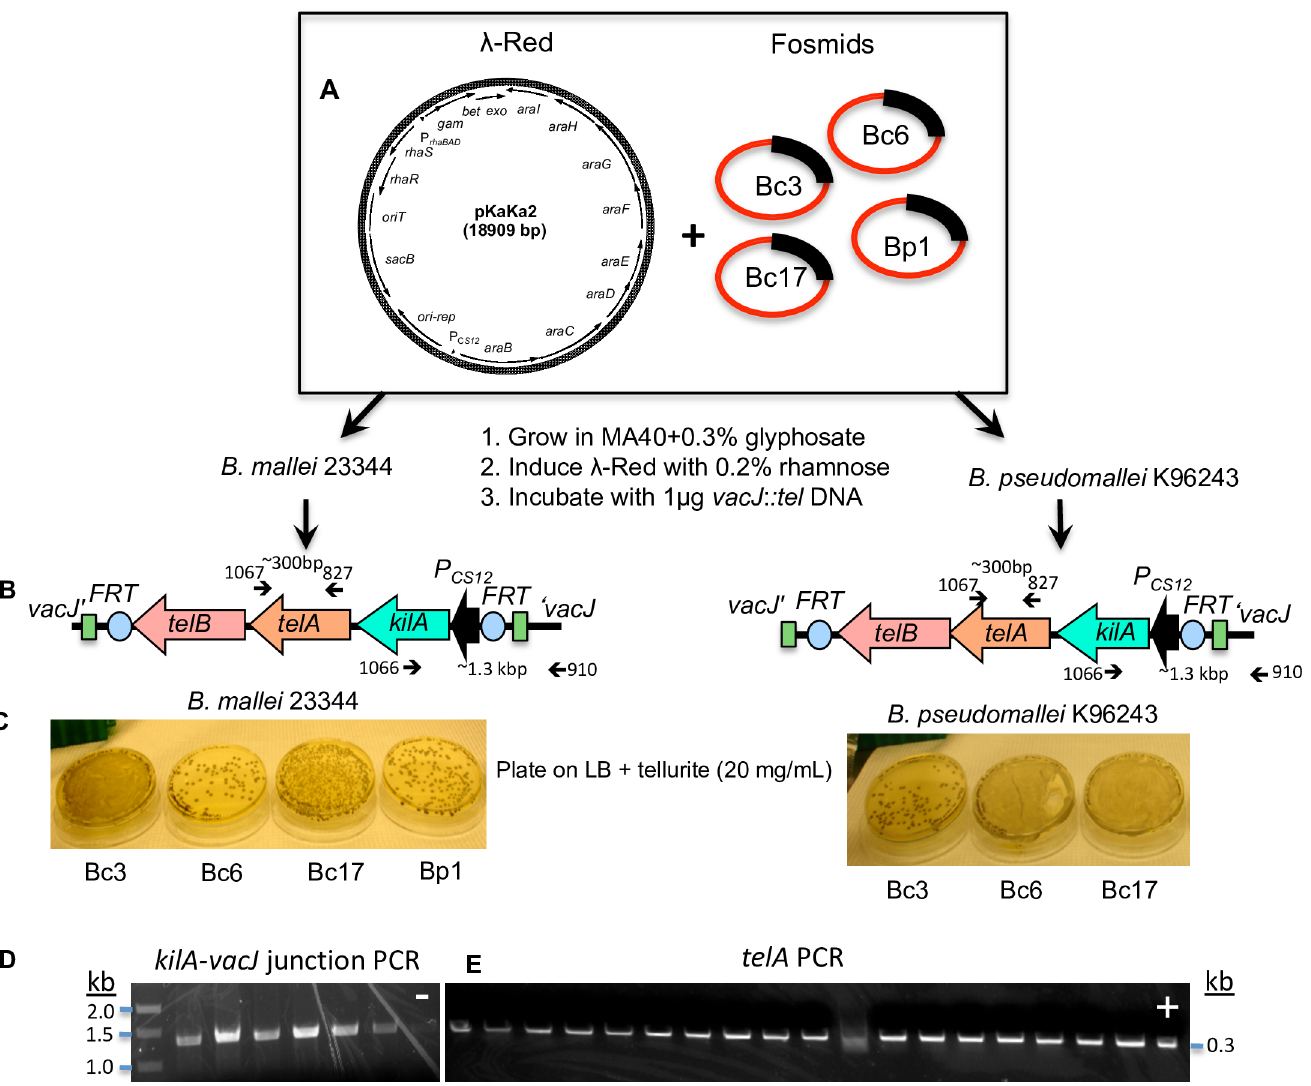
Fig 5. Allelic-replacement in B . mallei strain ATCC23344and B . pseudomallei K96243containing fosmids by natural transformation. (A) λ -Red plasmidpKaKa2and individualfosmid clones were co-transformed into B . mallei ATCC23344 and B . pseudomallei K96243. (B) PCR products